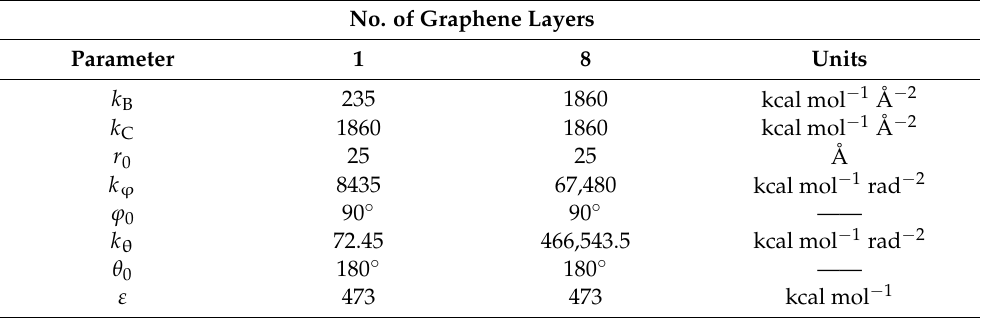
Table 1. The parameters of the main force field